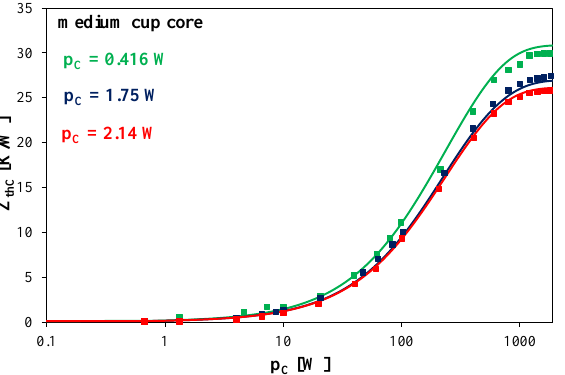
Figure 8. Measured and calculated waveforms of transient thermal impedance of the medium cup core at selected values of dissipated power.